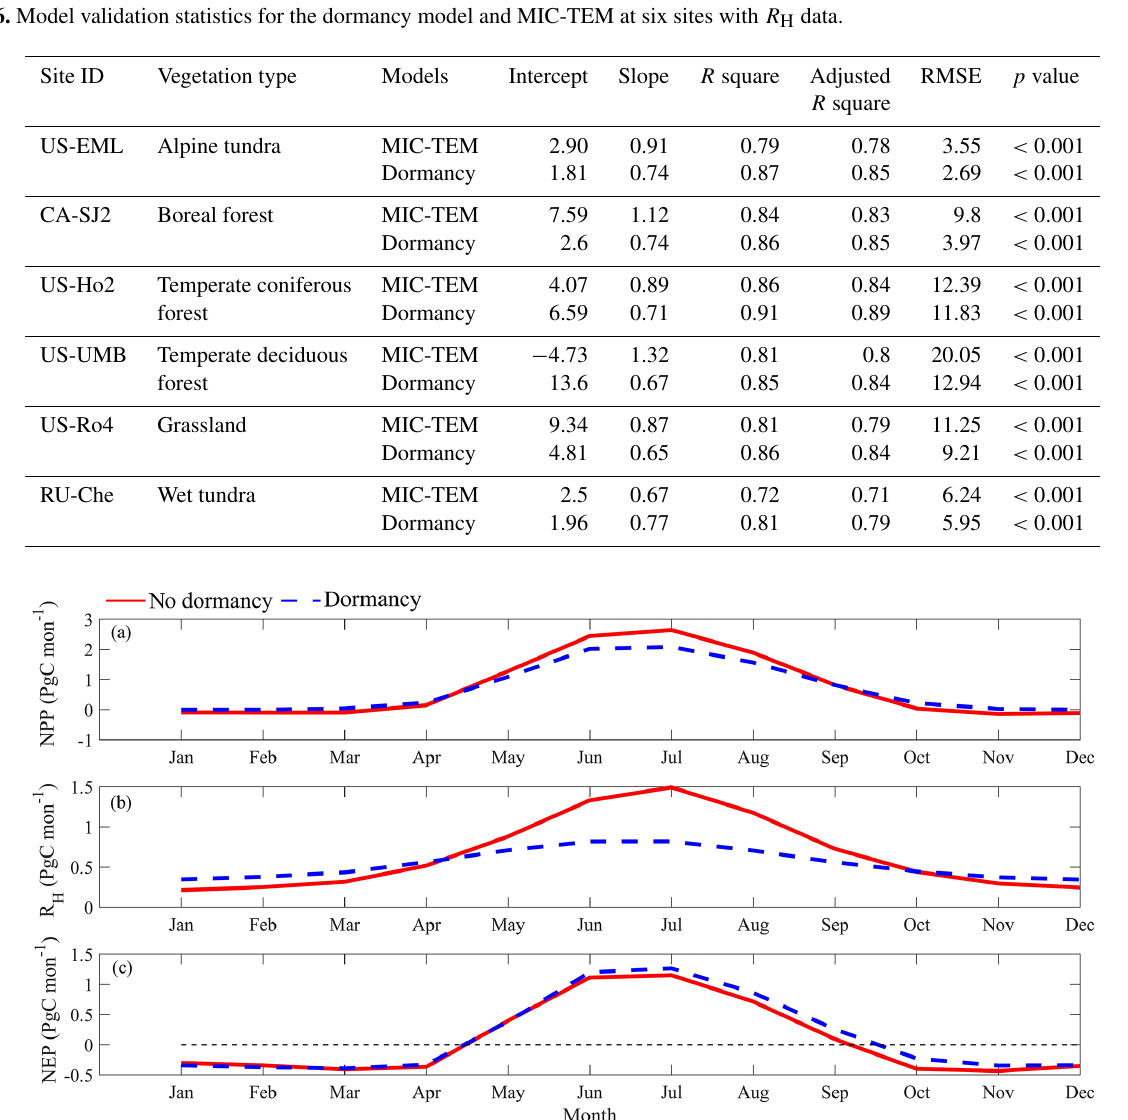
Figure 8. Regional annual seasonal pattern of simulated (a) net primary production (NPP, a ), (b) heterotrophic respiration ( R H , b ), and (c) net ecosystem production (NEP, c ) during the 1990s from the dormancy model and MIC-TEM. The region is all land areas north of 45 ◦